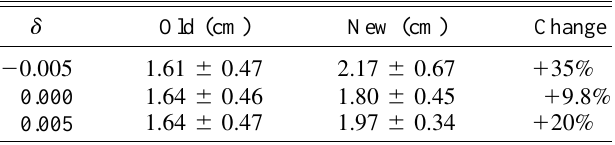
TABLE III. Dynamic aperture after 12 921 turns: first solution. d